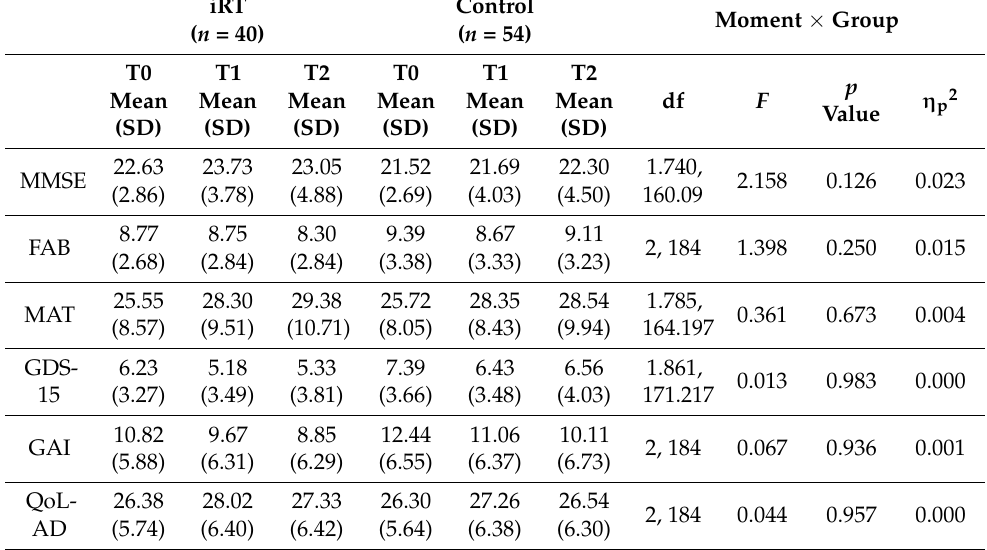
Table 2. Results of repeated-measures